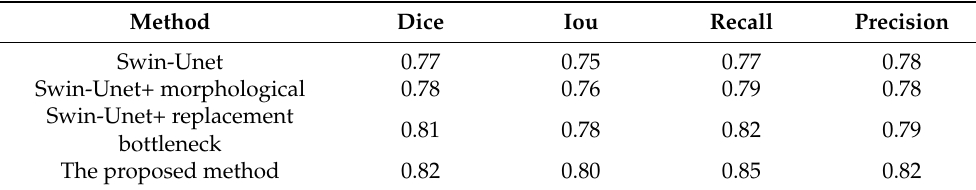
Table 4. The impact of methods based on different degrees of improvement on the model segmenta- tion ability on the overall dataset.